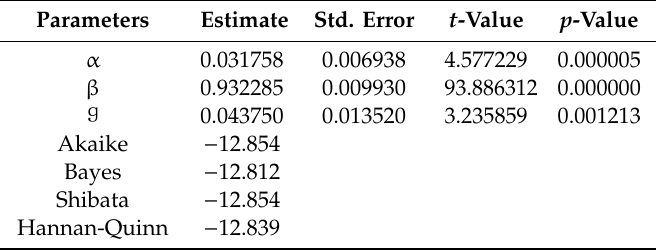
Table A1. Parameter Estimates of Hong Kong’s Islamic-conventional ADCC-GARCH model. Table A2. Parameter Estimates of New Zealand’s Islamic-conventional ADCC-GARCH model. Table A6. Parameter Estimates of Spain’s Islamic-conventional ADCC-GARCH model. Table A3. Parameter Estimates of China’s Islamic-conventional ADCC-GARCH model. Figure A4. Islamic-conventional stock returns Wavelet correlations for Americas’ region markets.